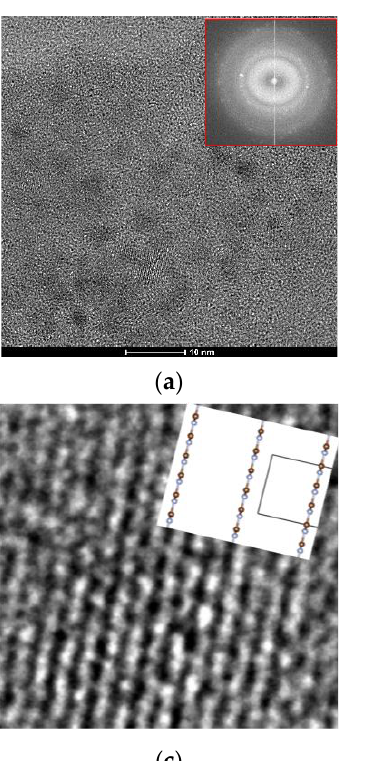
( d ) Figure 2. TEM observations on the graphene film nanostructures: ( a ) TEM image, ( b ) FTT image, ( c ) lattice stripe, ( d ) lattice spacing of graphene. Then, the crystal structure of CF 2 modified g-C 3 N 4 /graphene film (NG film) sample was detected, and the selected diffraction rings were (010) and (100) of g-C 3 N 4 after the